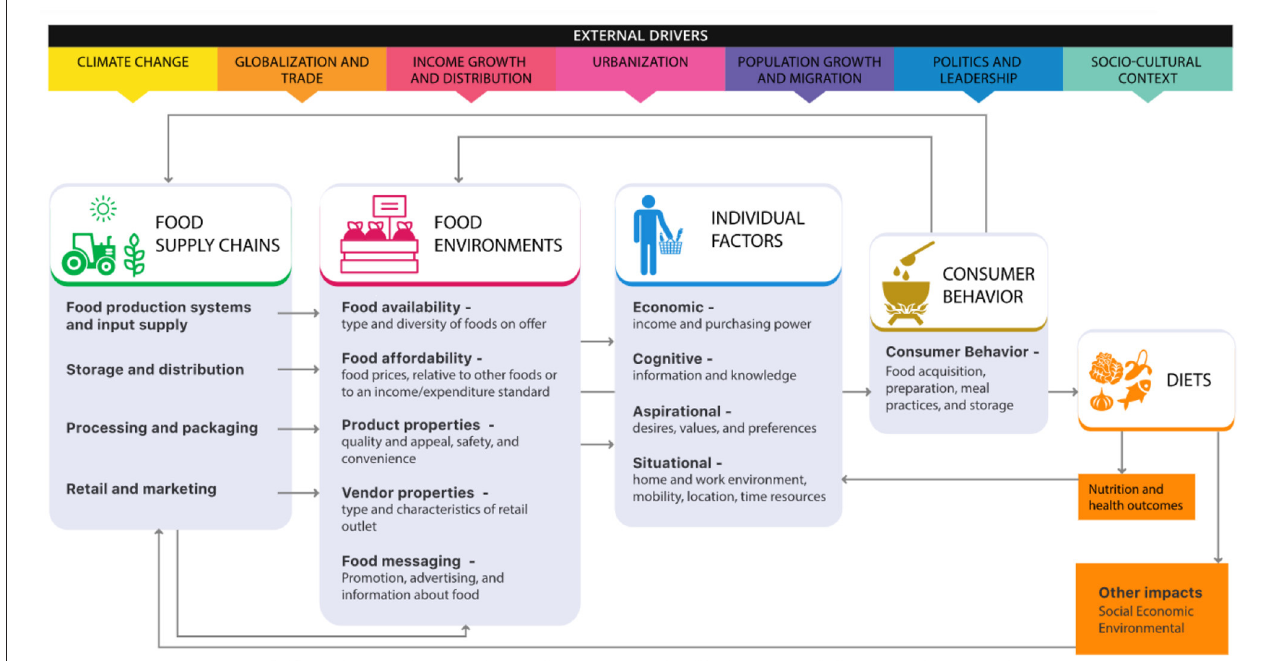
FIGURE 1 | A conceptual framework for food